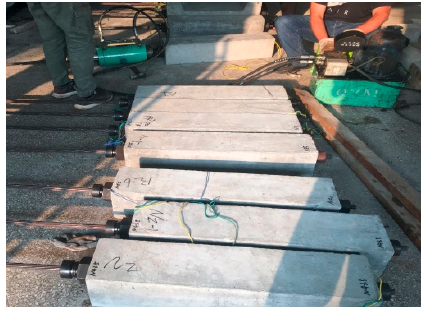
Figure 2. Prestress loading